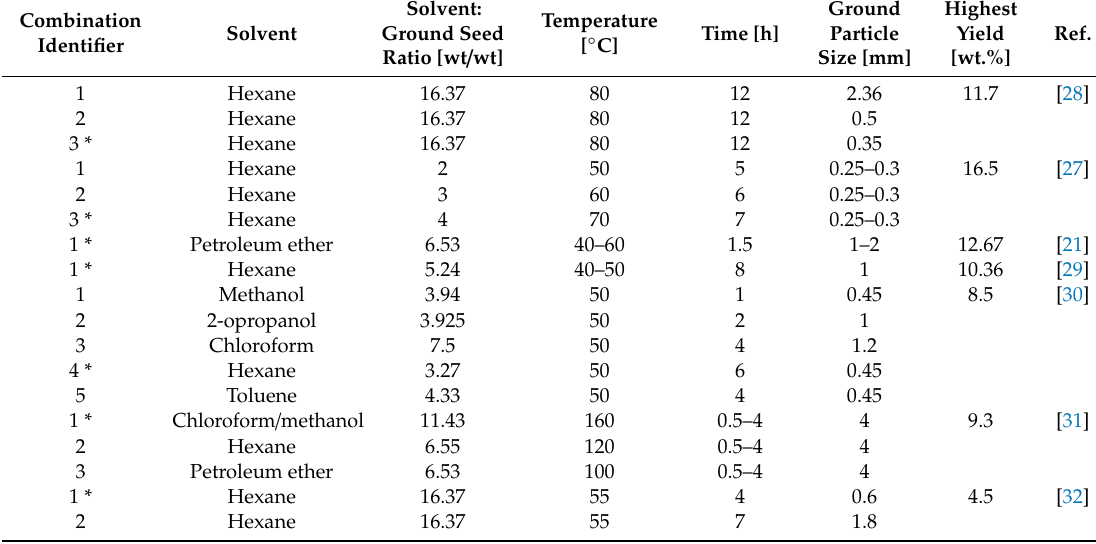
Figure 3. Date fruit and seed.